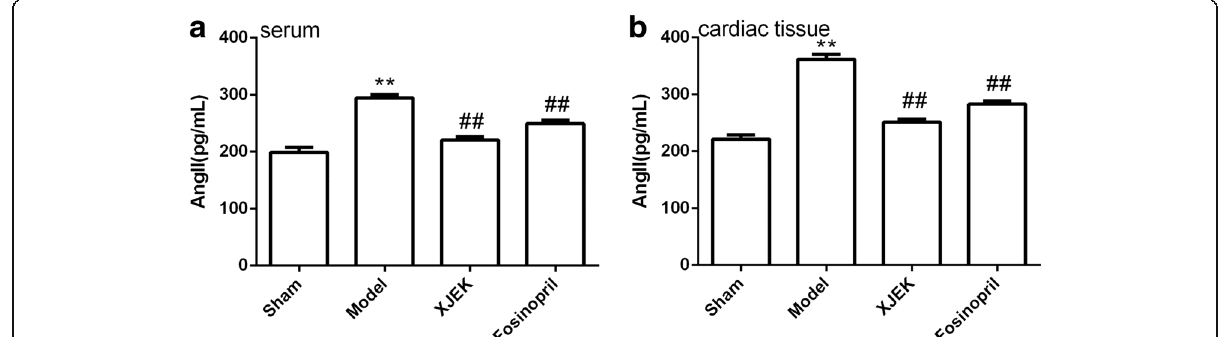
Fig. 7 Effect of XJEK on Ang II content in serum ( a ) and cardiac tissues ( b ) of MI mice (mean ± SEM, n = 6 – 9). * P < 0.05, ** P < 0.01 vs. Sham group; # P < 0.05, ## P < 0.01 vs. Model group